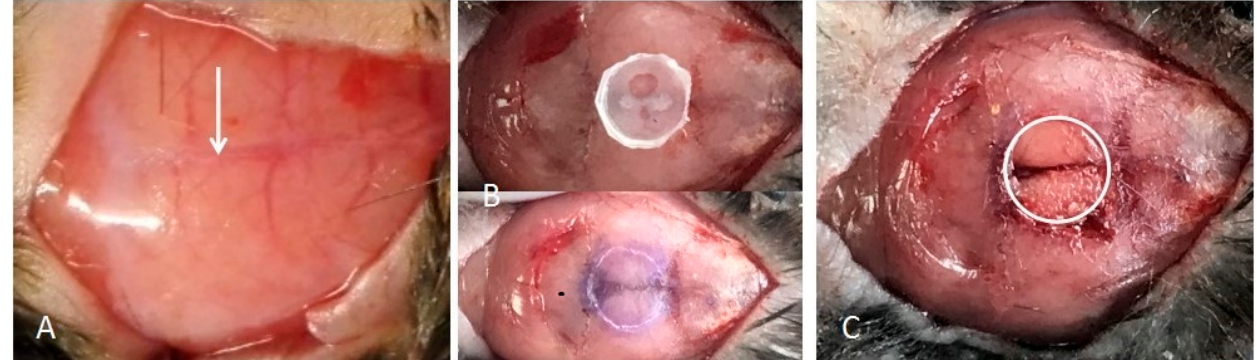
dle cranial suture. Arrow points to middle cranial suture. ( B ) Make a circular slice with a diameter of 5 mm and place it in the midline of the skull. Grind the skull along the edge of the slice unit and the bone is removed. ( C ) Separate the bone slice and expose the defect area.